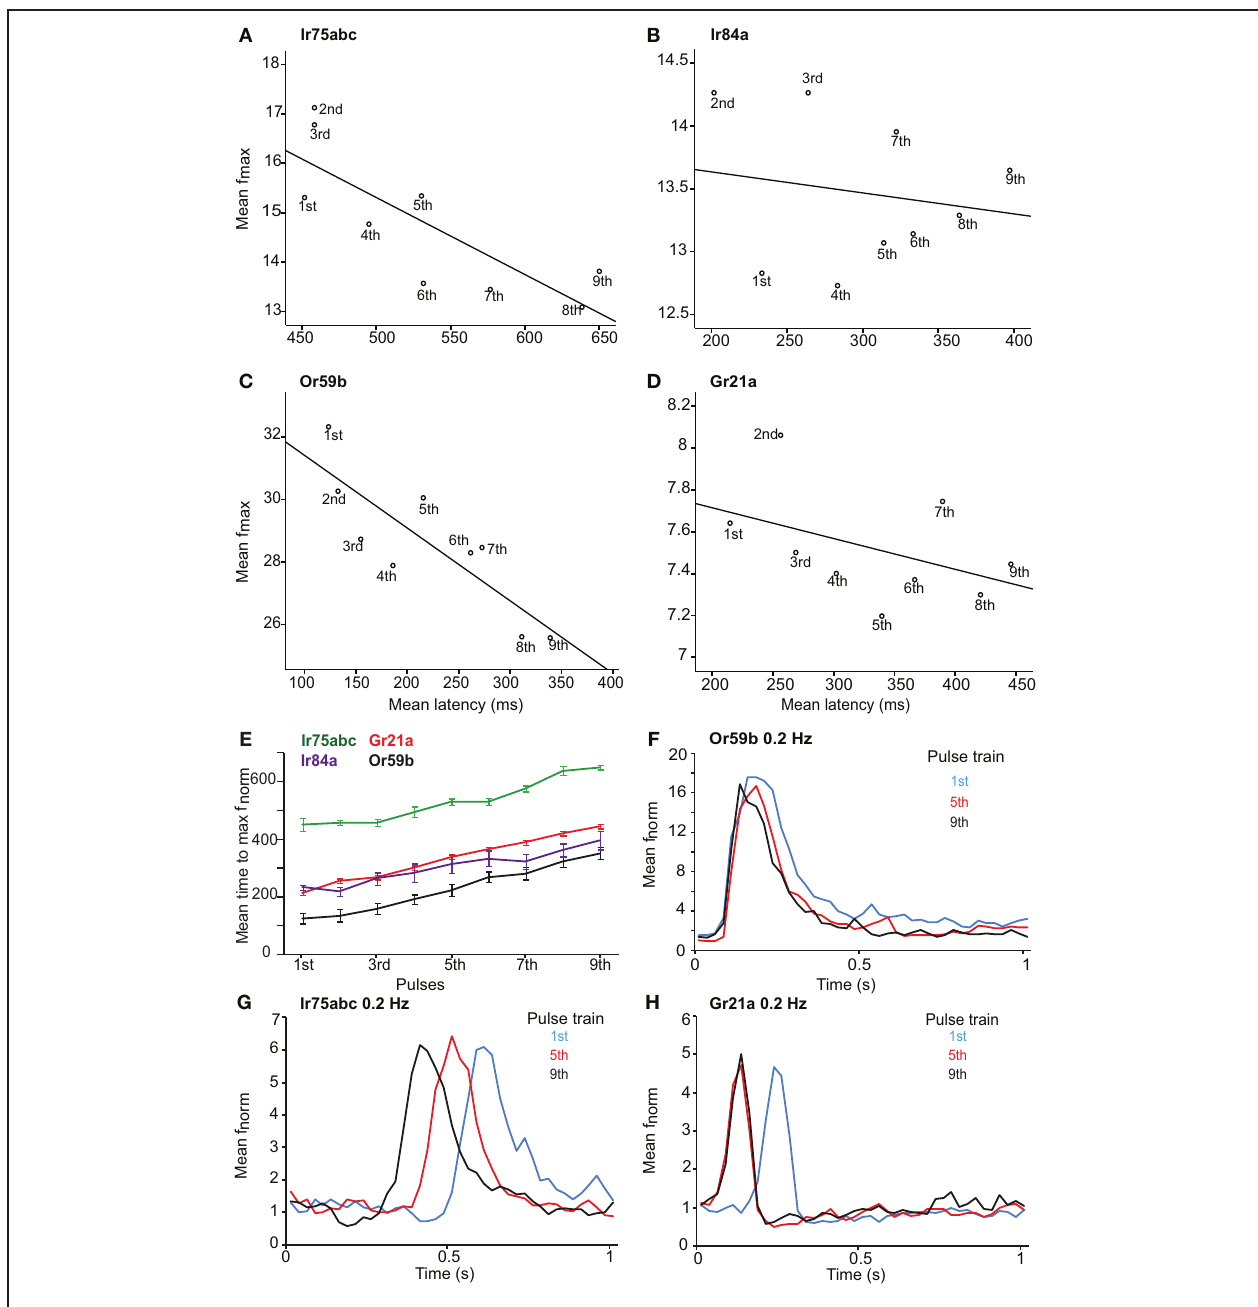
FIGURE 3 | Latency and maximum response of OSNs to repeated stimuli. Maximum response frequency vs. time to peak (latency), with best fit line, for OSNs carrying various receptors in response to repeated 1Hz stimulations. (A) Ir75abc, (B) Ir84a, (C) Or59b and (D) Gr21a. Pulse number (1–9) indicated below each point. (E) Mean time